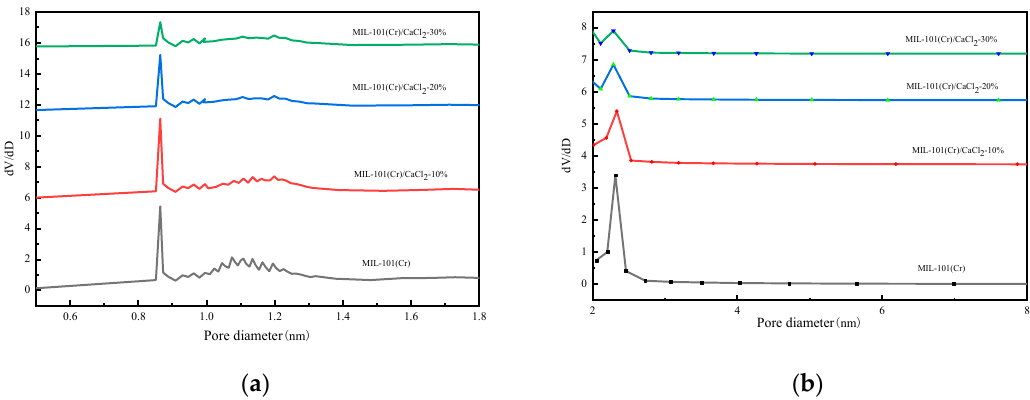
Figure 4. Pore diameter distribution of MIL-101(Cr) and MIL-101(Cr) / CaCl 2 composites: ( a ) micropore, ( b ) mesoporous. Table 1. Pore structure parameters of MIL-101(Cr) and composite materials. Sample BET Specific Surface Area (m 2 /